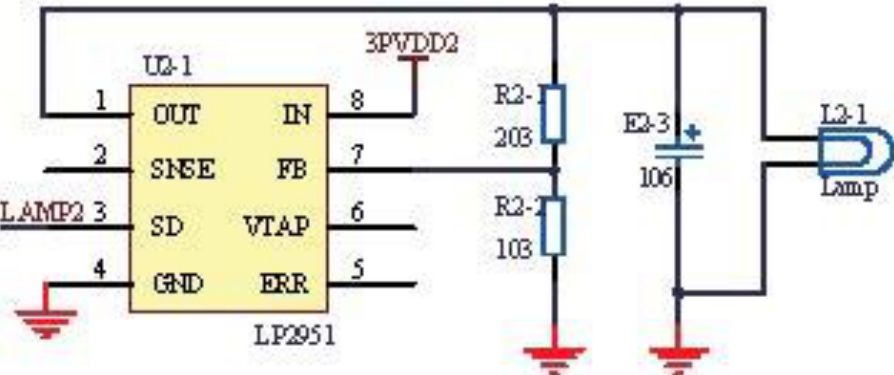
Figure 5. Application circuit of the infrared light source.